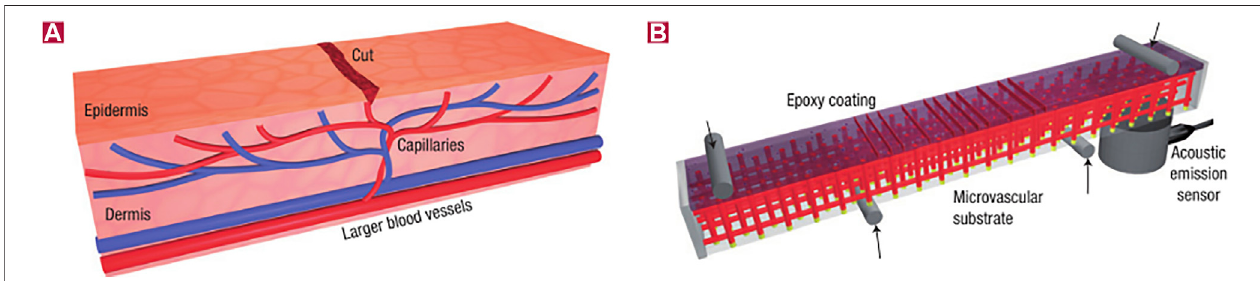
FIGURE 8 | Structure diagram of self-healing materials with 3D microvascular networks. (A) Dermal capillary network with a cut in the epidermis layer and (B) self- healing structure consisting of a microvascular substrate and an epoxy coating embedded with a catalyst in a four-point bending con fi guration monitored with an acoustic emission sensor (Toohey et al., 2007).